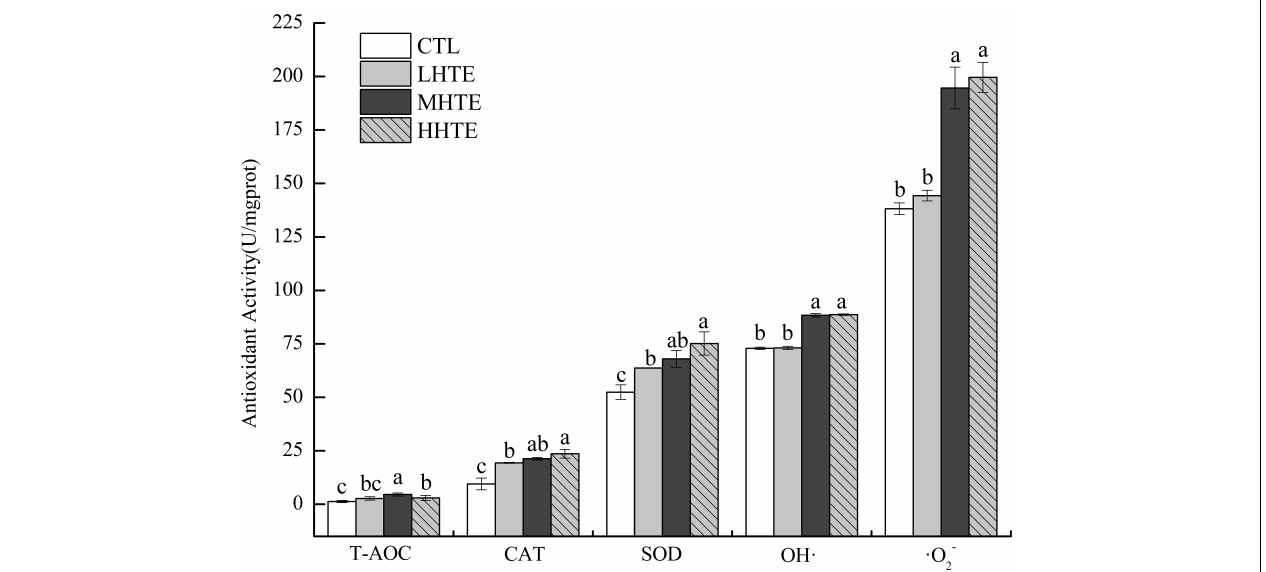
FIGURE 6 | Total antioxidant capacity (T-AOC), catalase (CAT) activity, superoxide dismutase (SOD) activity, and the inhibition for hydroxyl radical (OH · ) and superoxide anion ( · O 2 − ) of female flies under thermal stress fed a diet containing hsian-tsao extract (HTE) of low, medium, or high concentrations (LHTE, MHTE, or HHTE) or a non-HTE control diet (CTL) (90 female flies per group, 30 per replicate). Data show mean ± SD. Different lowercase letters indicate significant differences between groups (LSD test after one-way ANOVA, P < 0.05).